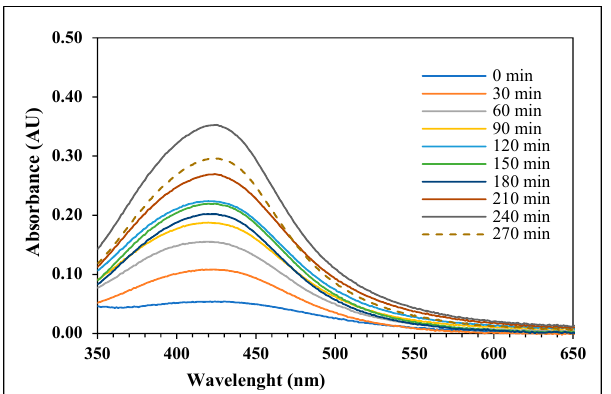
Figure 2. UV-visible spectra of the AgNPs showing the absorbance at different time intervals.